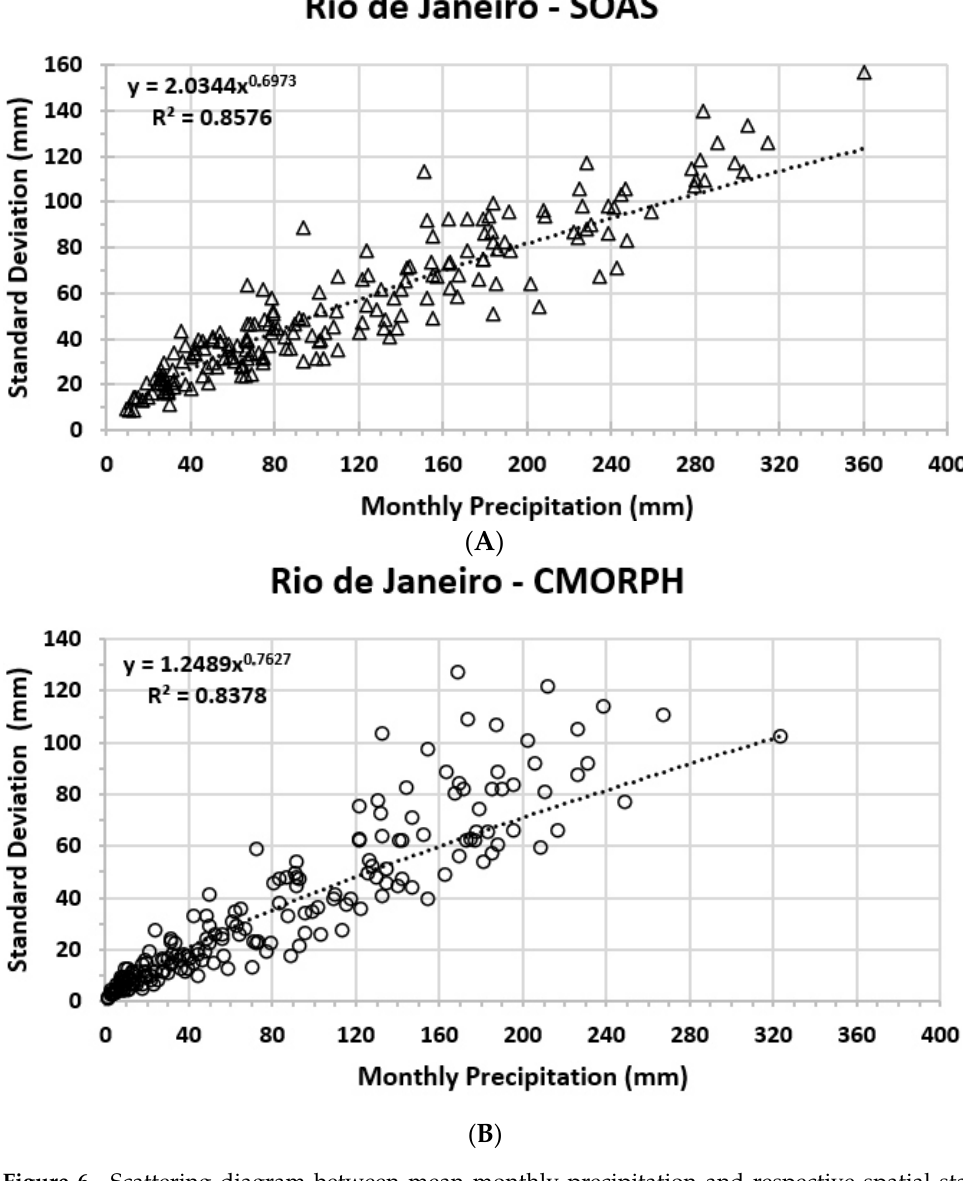
Figure 6. Scattering diagram between mean monthly precipitation and respective spatial standard deviation obtained with SOAS and the CMORPH method for all months of the year between 2000 and 2015 for the State of Rio de Janeiro. The exponential curve adjusted to the data, equation, and coe ffi cient of variation adjusted by the method of least squares are indicated.